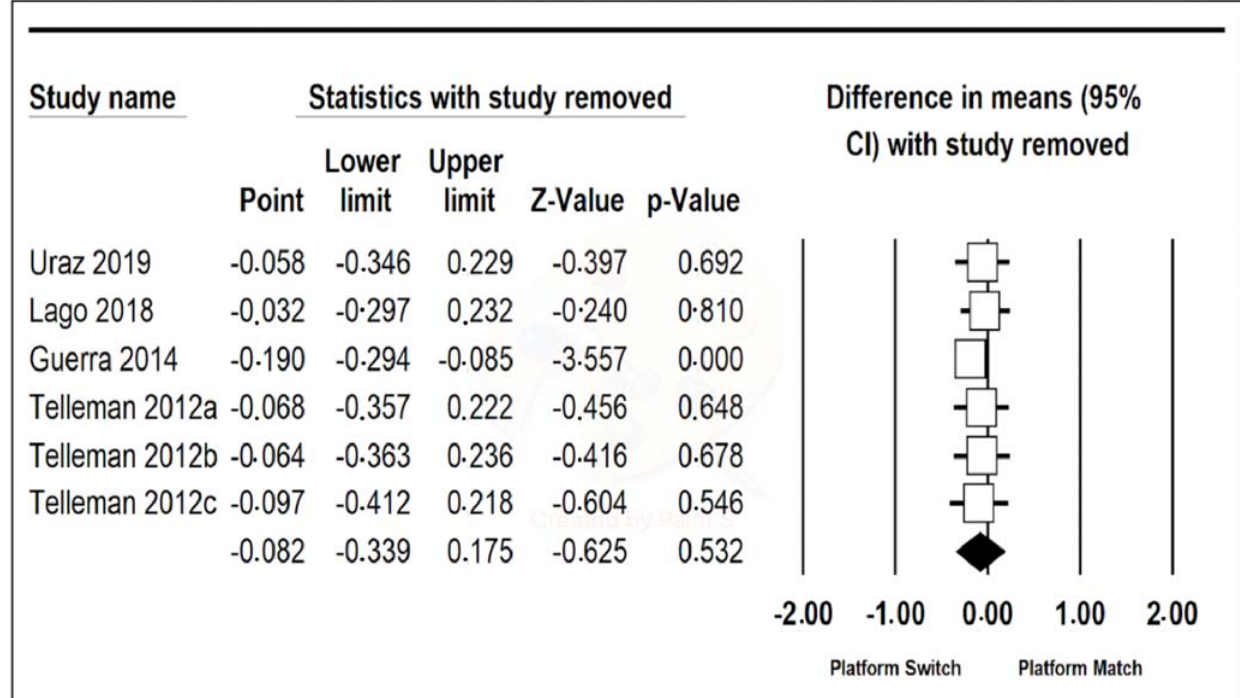
Figure 5. One Study Remove of increased probing depth.